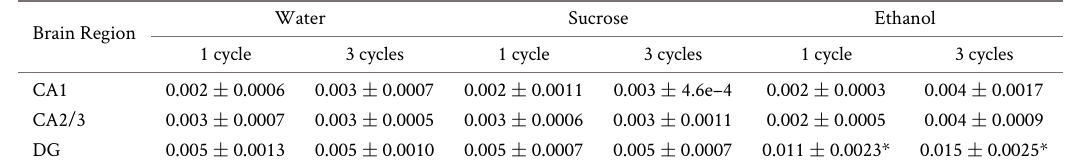
Table 2. Immunoreactivity per cell.